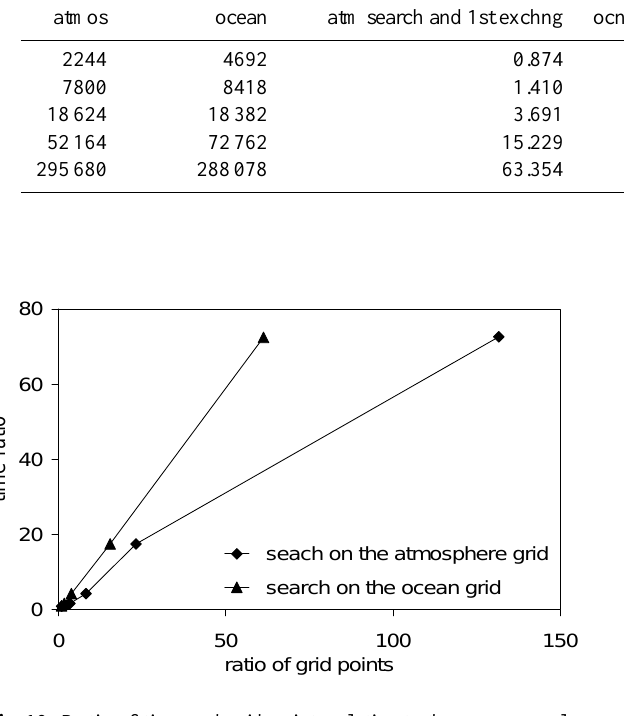
Fig. 10. Ratio of time and grid points relative to the coarse resolu- tion test (T21 (cid:29) 4 ◦ ) for the OASIS4 search based on the